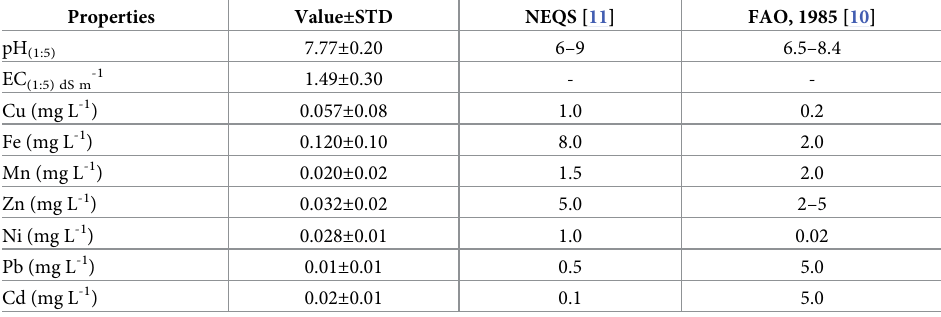
Table 2. pH, EC and heavy metal concentrations of waste water used in the study along with permissible limits for irrigation water.